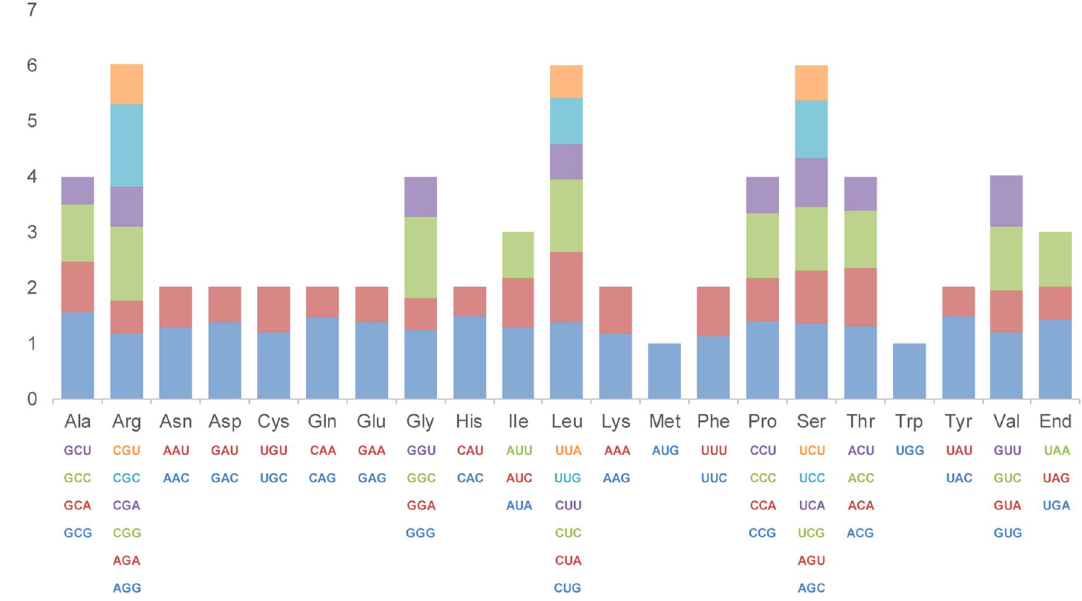
Figure 2. RSCU based on PCGs of the mt genome of G. sinensis .